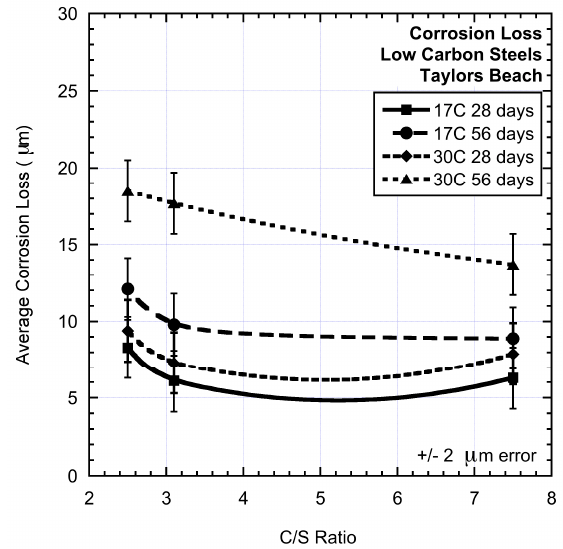
Figure 5. Corrosion losses as a function of the ratio C/S of carbon content/sulphur content, with ±2 μ m error bars. The error bars shown are indicative but based on results from an earlier study of the variability in average corrosion loss at the same site for mild steels [39].